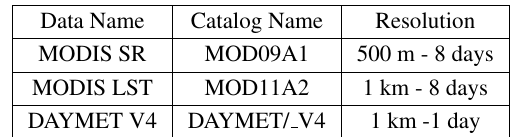
Table 1. Image dataset utilized in this study.